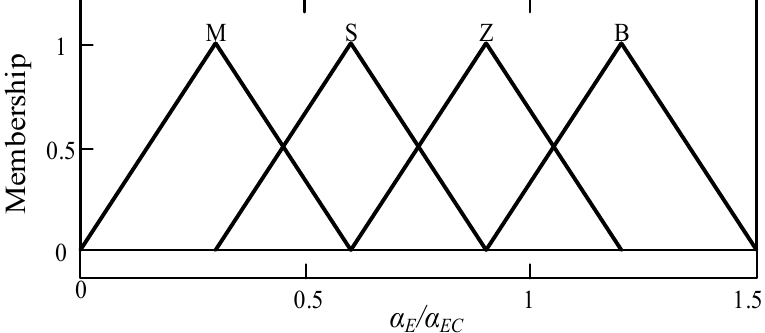
Figure 6. Membership functions of α E and α EC .